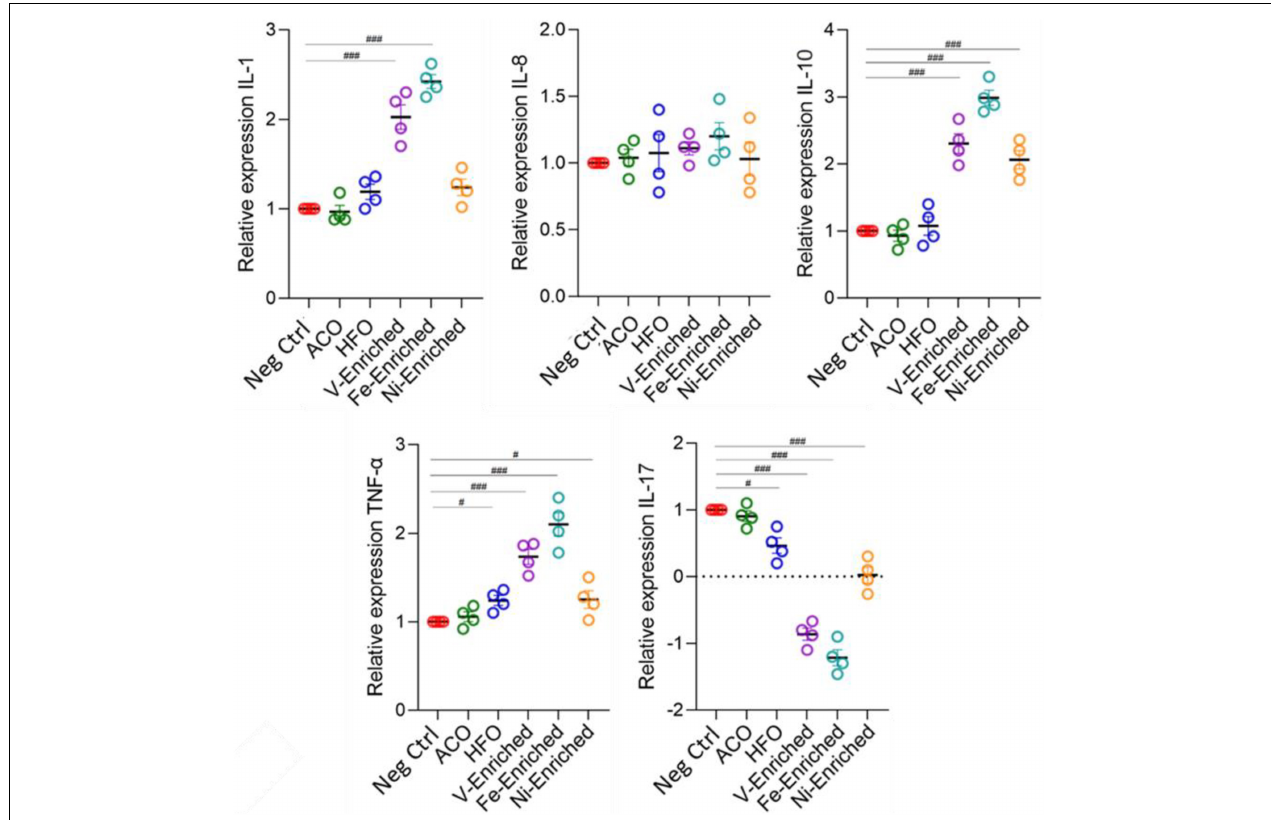
FIGURE 6 | Expression of cytokine genes (fold changes relative to negative control) in the gut of juvenile Lates calcarifer exposed to petroleum hydrocarbons and metals. One-way ANOVA with the Dunnett post hoc test was carried out. # Significant at an α -level of 0.05. ## Significant at an α -level of 0.005. ### Significant at an α -level of 0.001. Abbreviations: ACO, Australian crude oil; HFO, heavy fuel